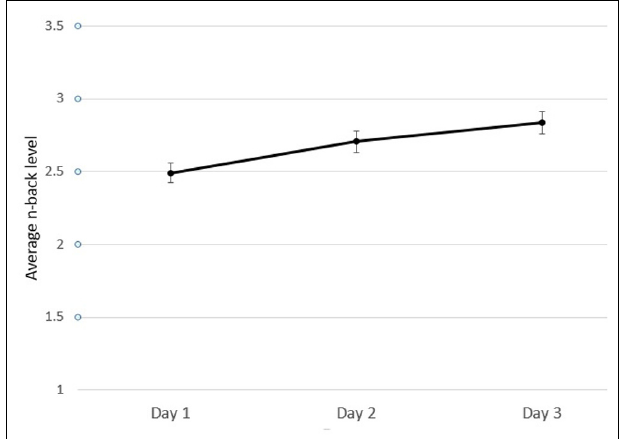
FIGURE 3 |Average game performance (n-back level) across all individuals on each day. Error bars represent standard error.